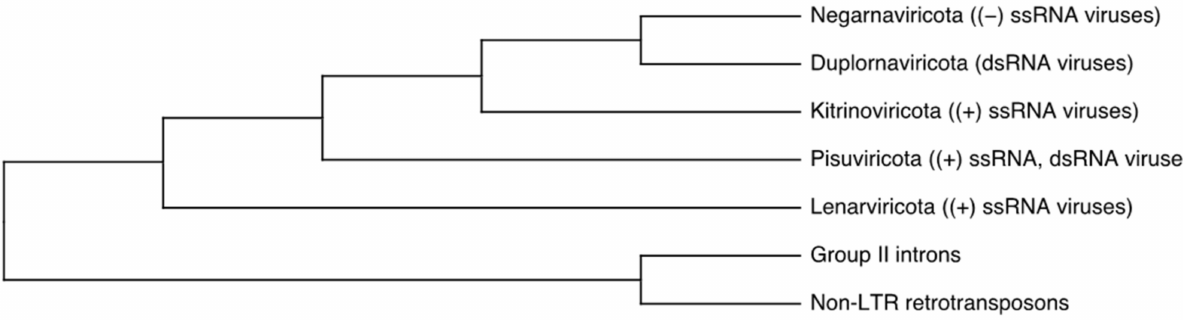
Figure 1. Phylogenetic analysis of RNA-dependent RNA polymerase (RdRp) of RNA viruses with reverse transcriptase (RT) used as an outgroup to root the tree. Five major branches have been assigned a phylum rank by Internationational Committee on Taxonomy of Viruses (ICTV): Branch 1 = Lenarviricota, Branch 2 = Pisuviricota, Branch 3 = Kitrinoviricota, Branch 4 = Duplornaviri- cota, and Branch 5 = Negarnaviricota. Adapted from